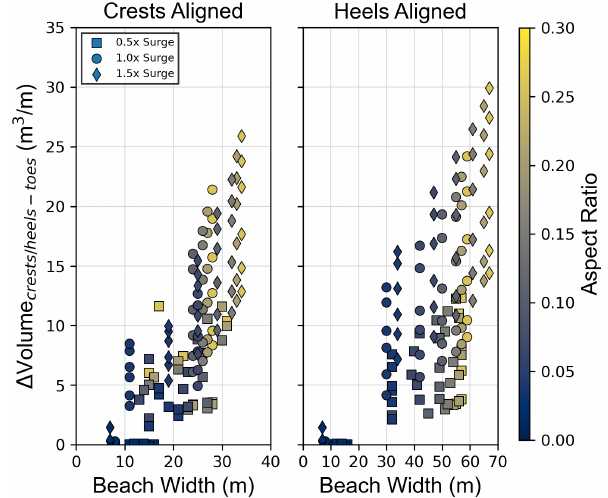
Figure 11. Volume loss from the crest- and heel-aligned simula- tions minus volume loss from the equivalent toe-aligned scenarios versus the initial beach width for the crest- and heel-aligned simula- tions. The color corresponds to the dune aspect ratio and the shape corresponds to the storm surge